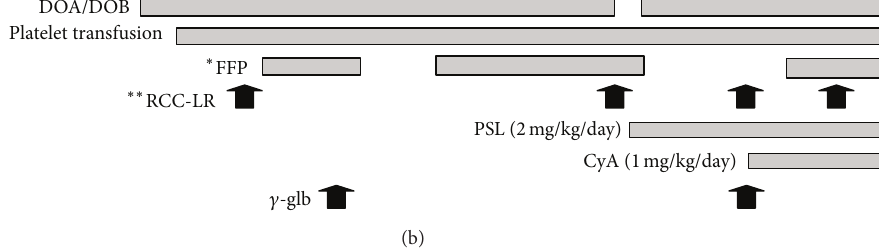
Figure 1: (a) Clinical course which is related to liver dysfunction. This figure shows the laboratory findings that are related to liver function. In a few days after birth, severe liver failure with a dominant increase in unconjugated bilirubin was evident. After that, aspartate aminotransferase and alanine aminotransferase levels were decreased; on the other hand, conjugated bilirubin level was increased. (b) Clinical course while she was hospitalized. This figure shows the clinical course of the patient. Thrombocytopenia did not improve after continuous platelet transfusion. Administration of vitamin B1, vitamin B2, vitamin C, Carnitine, and Coenzyme Q10 is a supporting